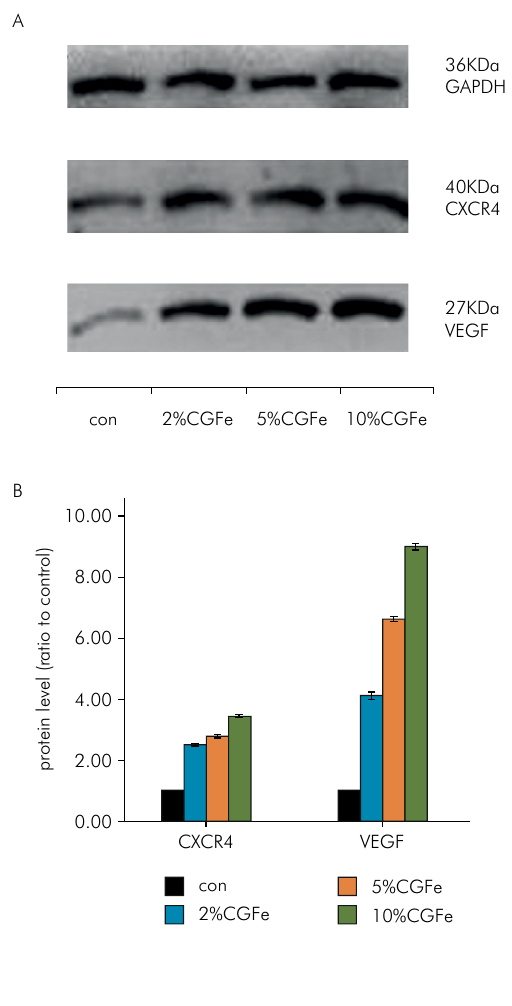
Figure 5. Expression levels of CXCR4 and VEGF determined by Western blotting. Western blot analysis showed that CGFe upregulated the CXCR4 and VEGF protein expression levels. (A) Representative images of three independent experiments are shown above. (B) Bands were quantified using Gel-Pro Analyzer 4.0(Sigma-Aldrich, USA). The expression of VEGF and CXCR4 rose in a positive dose-dependent manner (p <